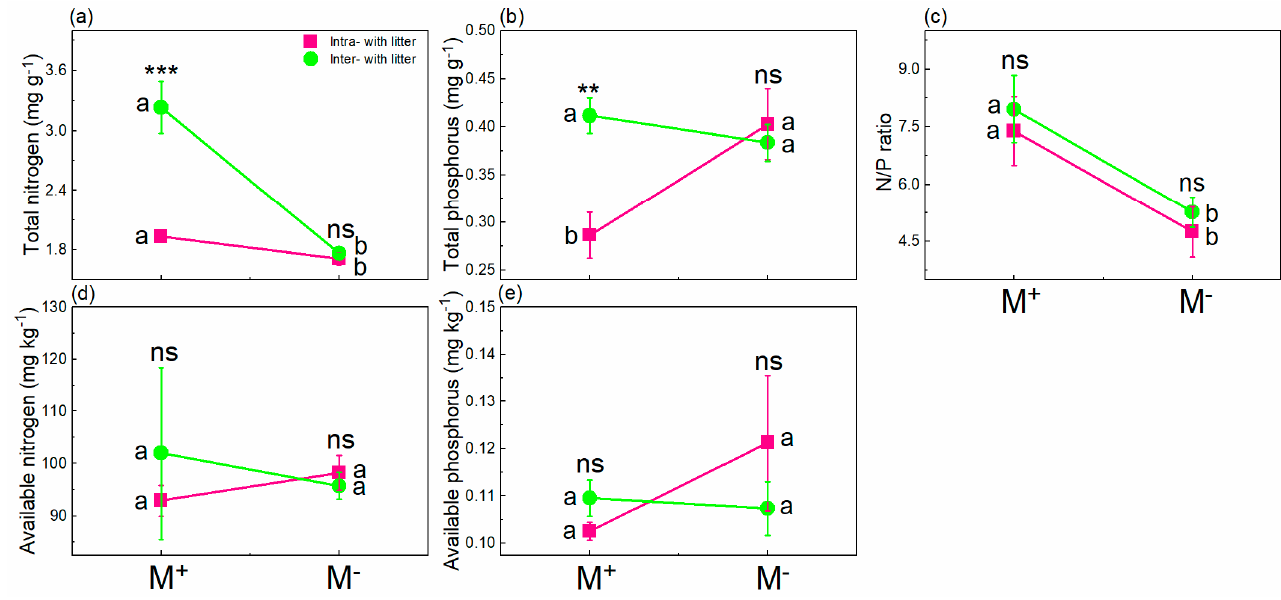
Figure 4. The soil nutrient properties on the total nitrogen and phosphorus ( a , b ) and the N/P ratio ( c ) and the available